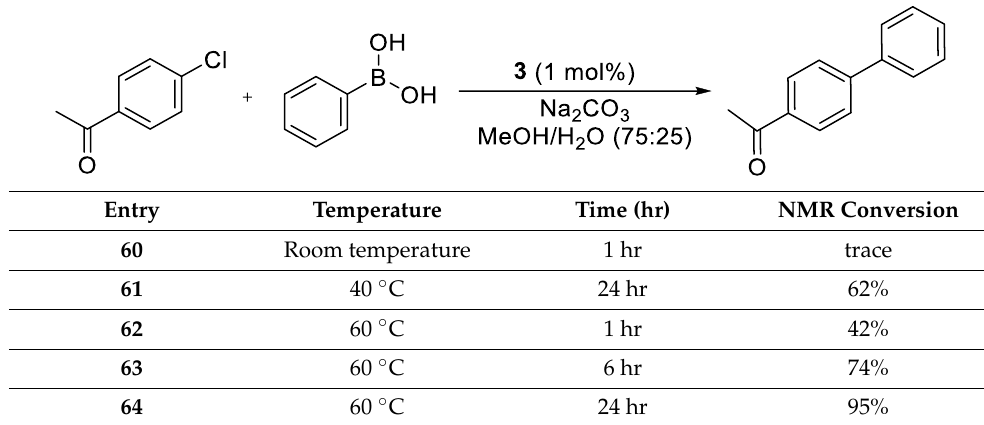
Table 8. Cross-coupling reaction between 4–chloroacetophenone and phenyl boronic acid in varying conditions.